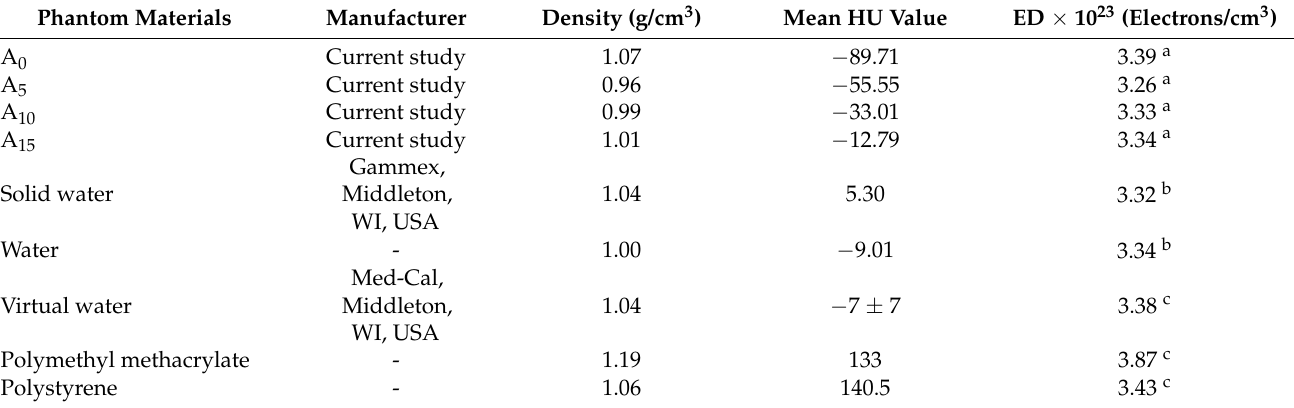
Table 3. Parameters of various standard phantom materials compared with DSF/NaOH/IA-PAE/ R.